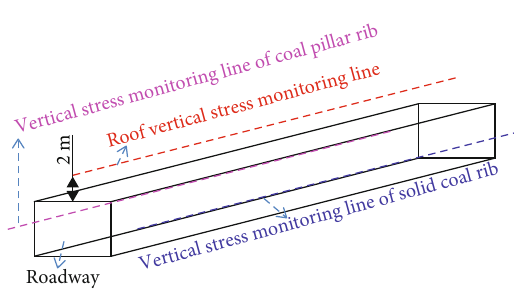
Roadway Figure 4: Layout of vertical stress monitoring line of roadway surrounding